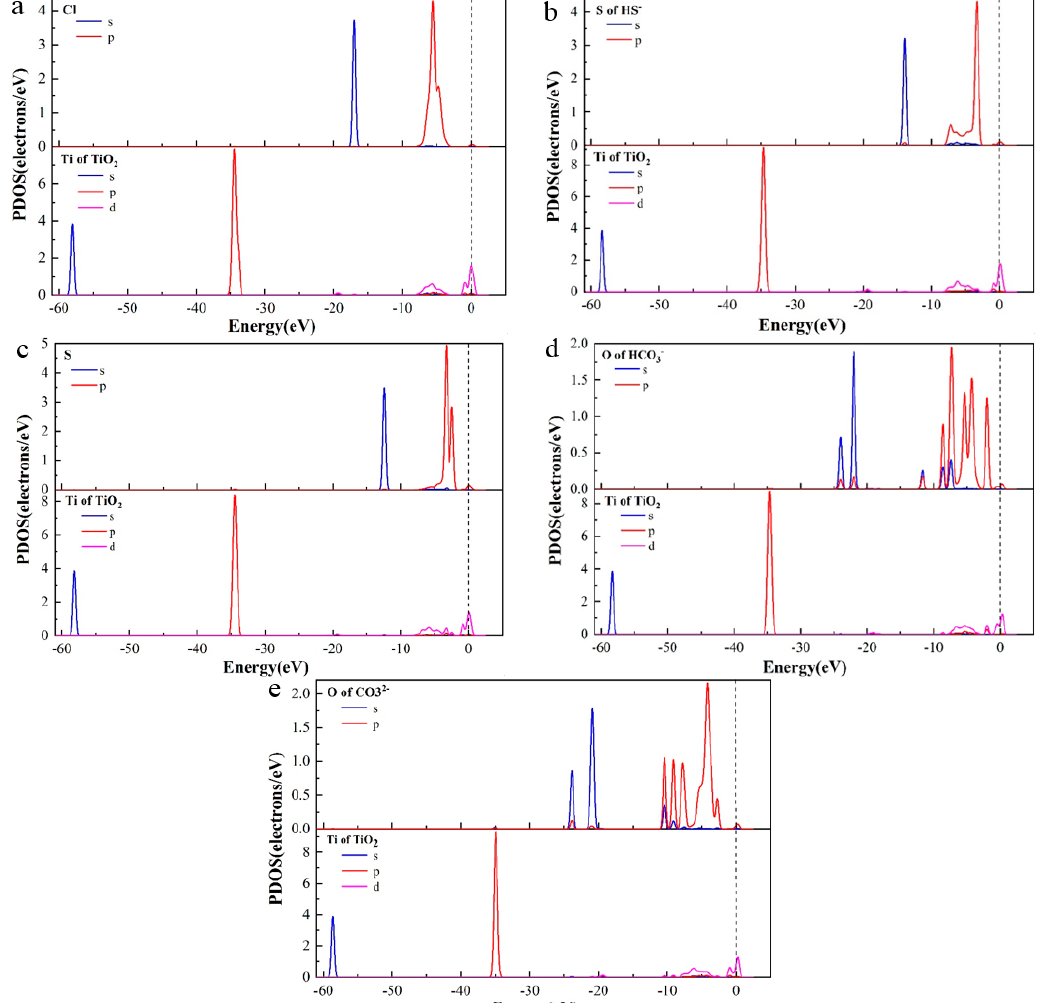
Figure 5. PDOS curves of ( a ) Cl − , ( b ) HS − , ( c ) S 2 − , ( d ) HCO 3 − , and ( e ) CO 32 − adsorbing on the TiO 2 (100) surface at the bridge site.